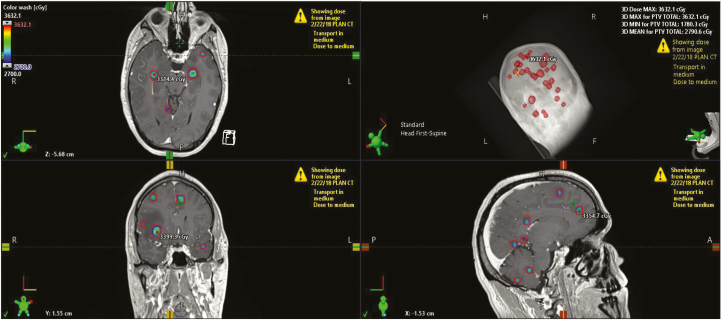
 An example of a patient treated using single-isocenter multitarget radiosurgery for 30 brain lesions. The total volume of brain tumor (GTV total) is 4.7 cc. A 2–3 mm planning target volume (PTV) was used with 24 Gy prescribed to the PTV total and 27 Gy to the gross tumor volume total in 3 fractions. Treatment delivered with 5 volumetric modulated arc therapy arcs.